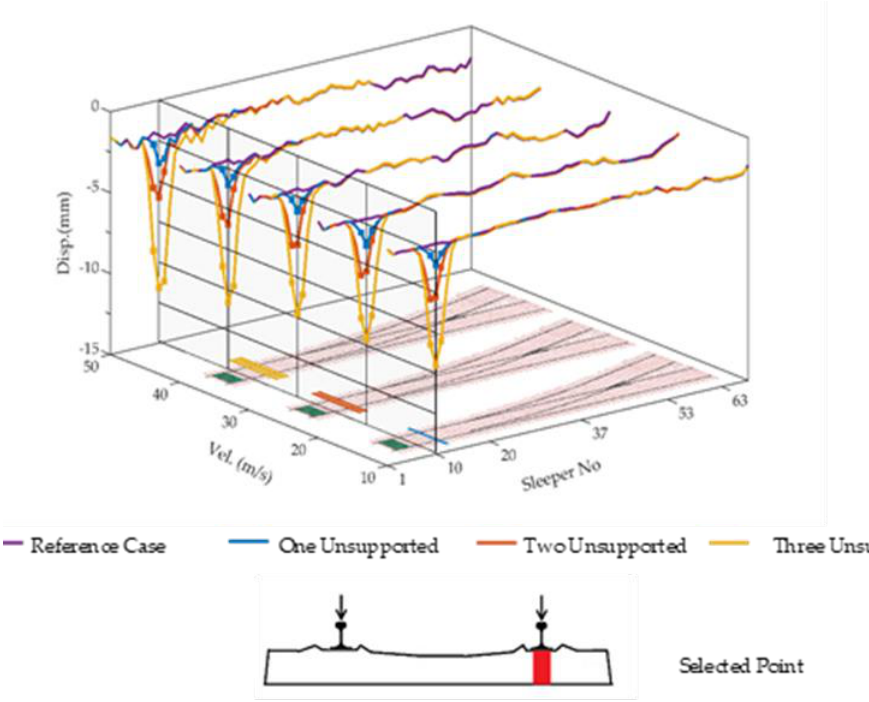
Figure 4. The maximum displacement of bearers at rail seats when an unsupported bearer exists at normal track section.